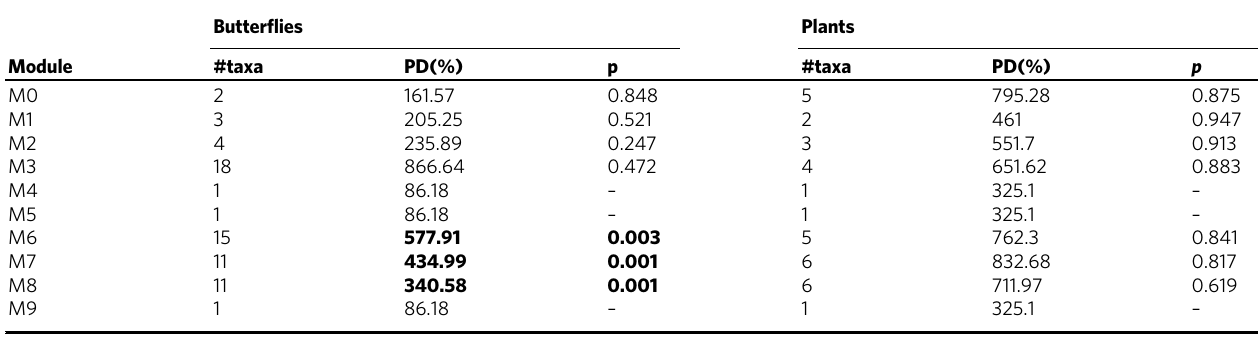
Table 2 Phylogenetic diversity (PD) of butter fl ies and plants for each module on the Pieridae-plant network Butter fl